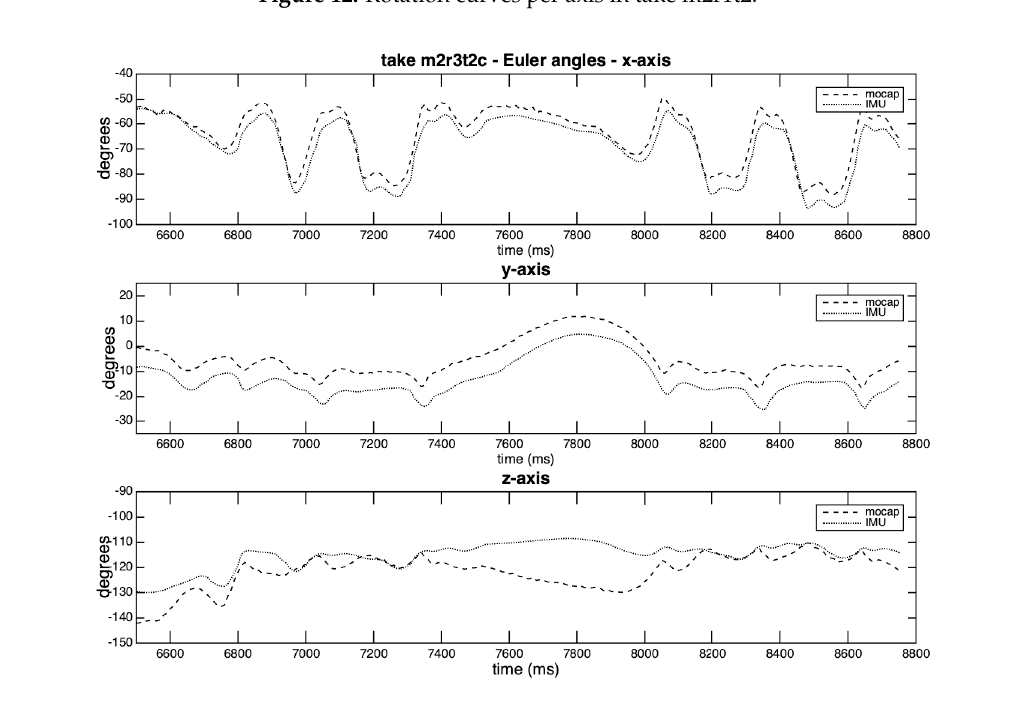
Figure 13. Rotation curves per axis in take